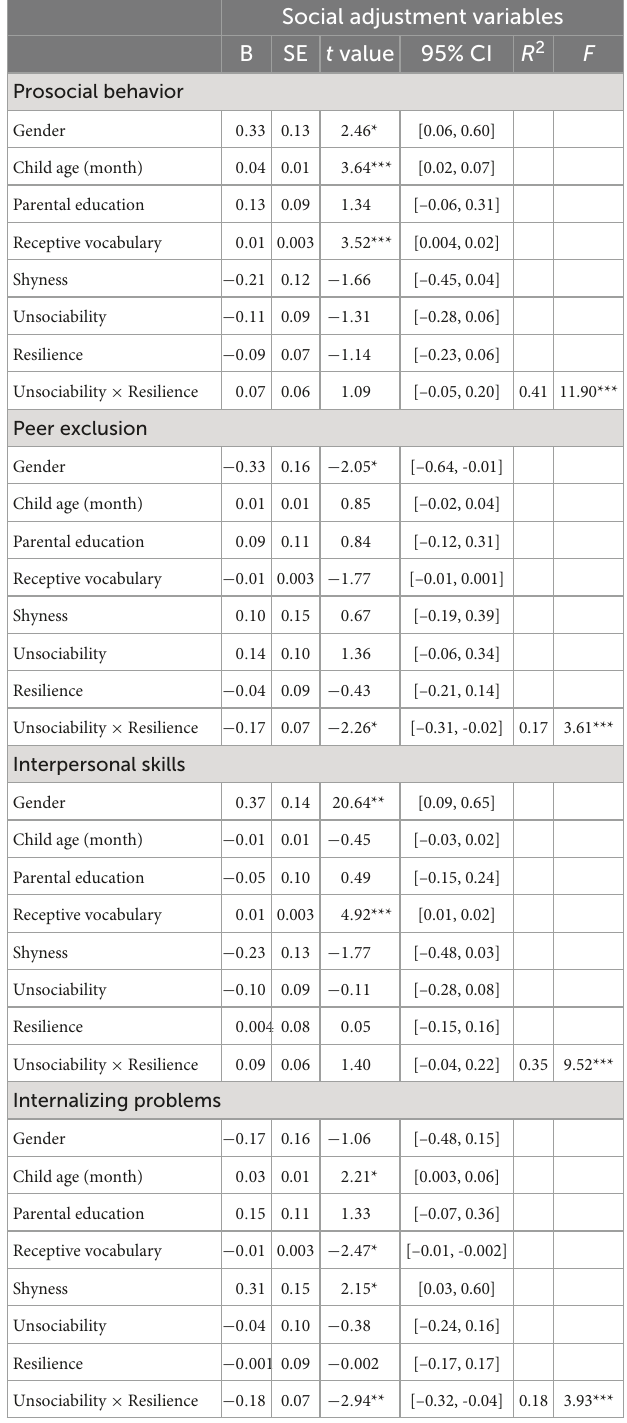
TABLE 2 Main and moderating effects of unsociability and resilience on indices of social